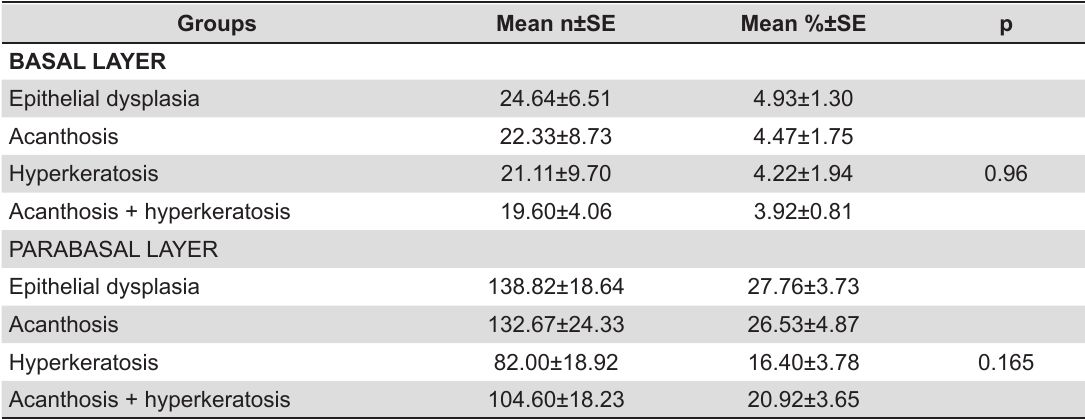
Table 3- Distribution across groups of mean numbers and mean percentages of p21 WAF1 positive cells with standard errors (±SE) for the basal and parabasal layers